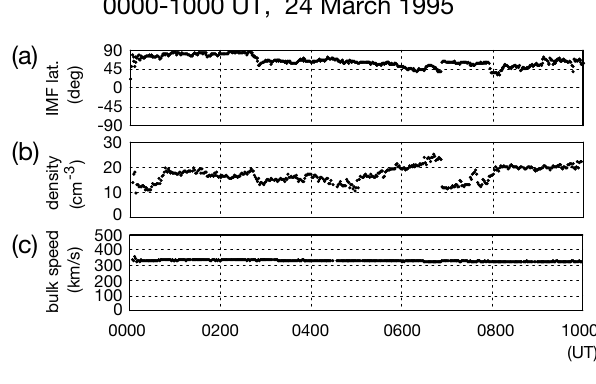
Fig. 1. Solar wind data between 00:00–10:00 UT on 24 March 1995 obtained by the Wind spacecraft. From the top, (a) latitudinal angle of the IMF, (b) proton density, and (c) bulk flow speed are